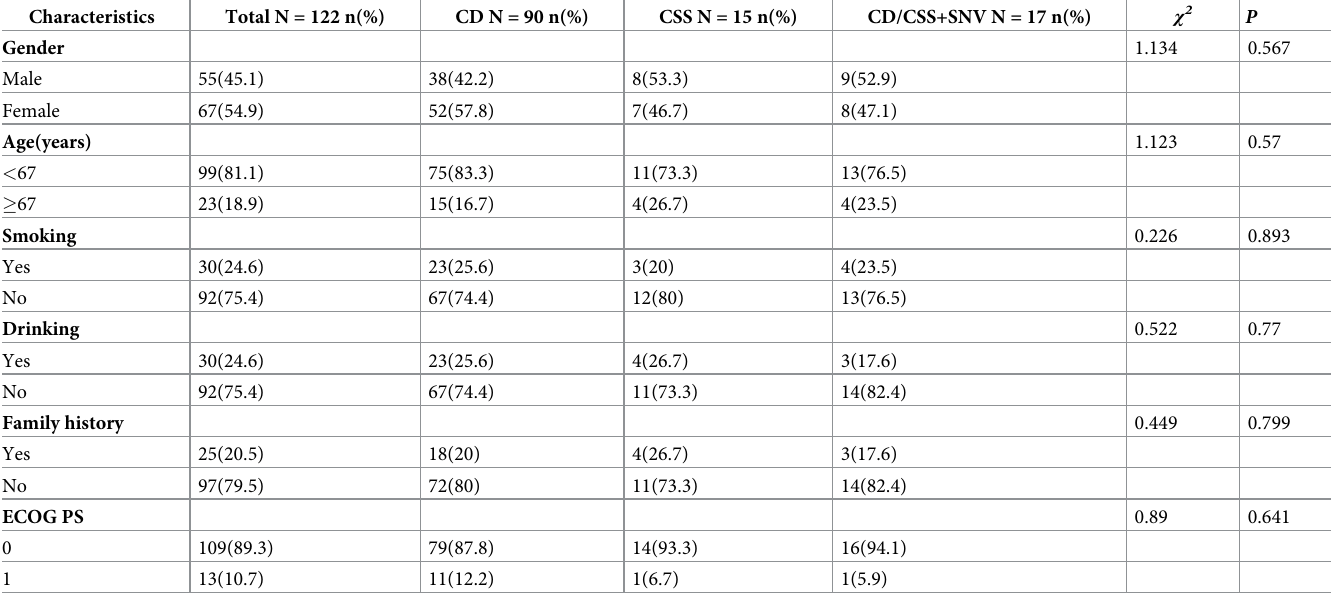
Table 3. Clinical characteristics of three groups. Characteristics